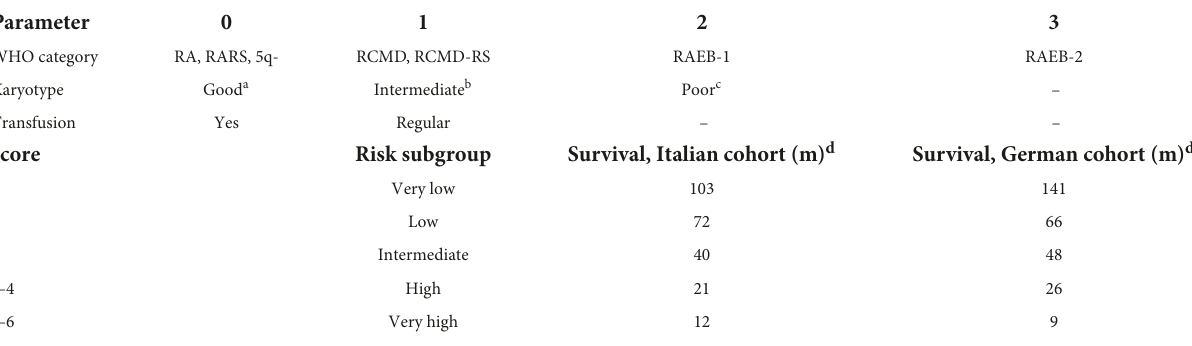
TABLE 2 WHO classification-based prognostic scoring system (WPSS) scoring system